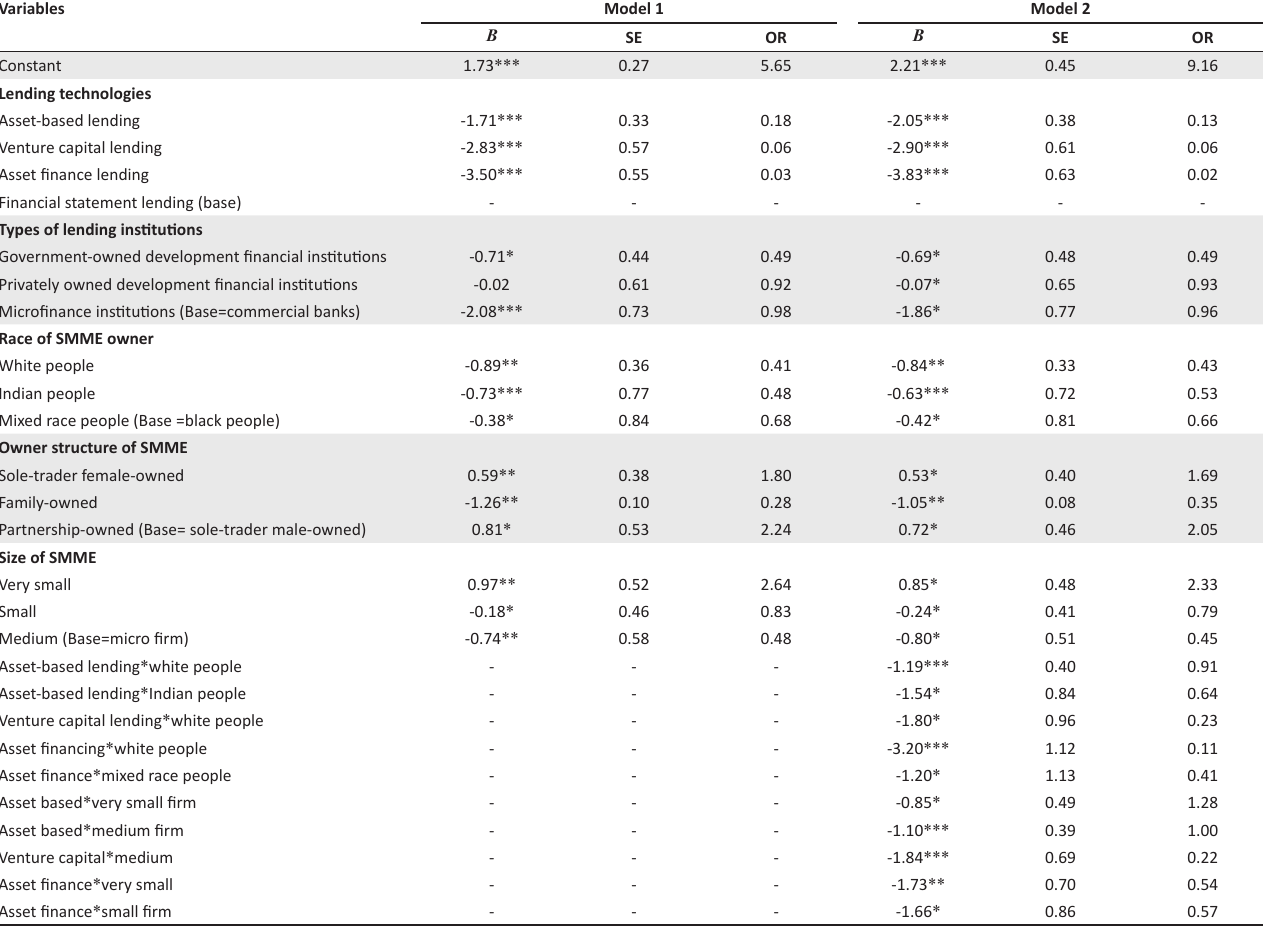
TABLE 2: Small, micro and medium enterprises and lender characteristics effects on credit